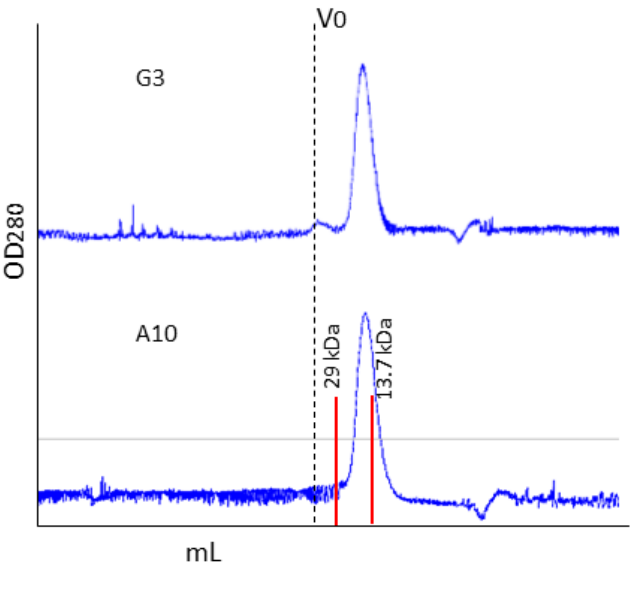
Figure 3. Gel filtration of immunopurified VHH fractions The elution fractions corresponding to the VHH antibodies G3 and A10, immunopurified using the anti-C tag resin, have been purified by gel filtration to evaluate their monodispersity and aggregation/oligomerization